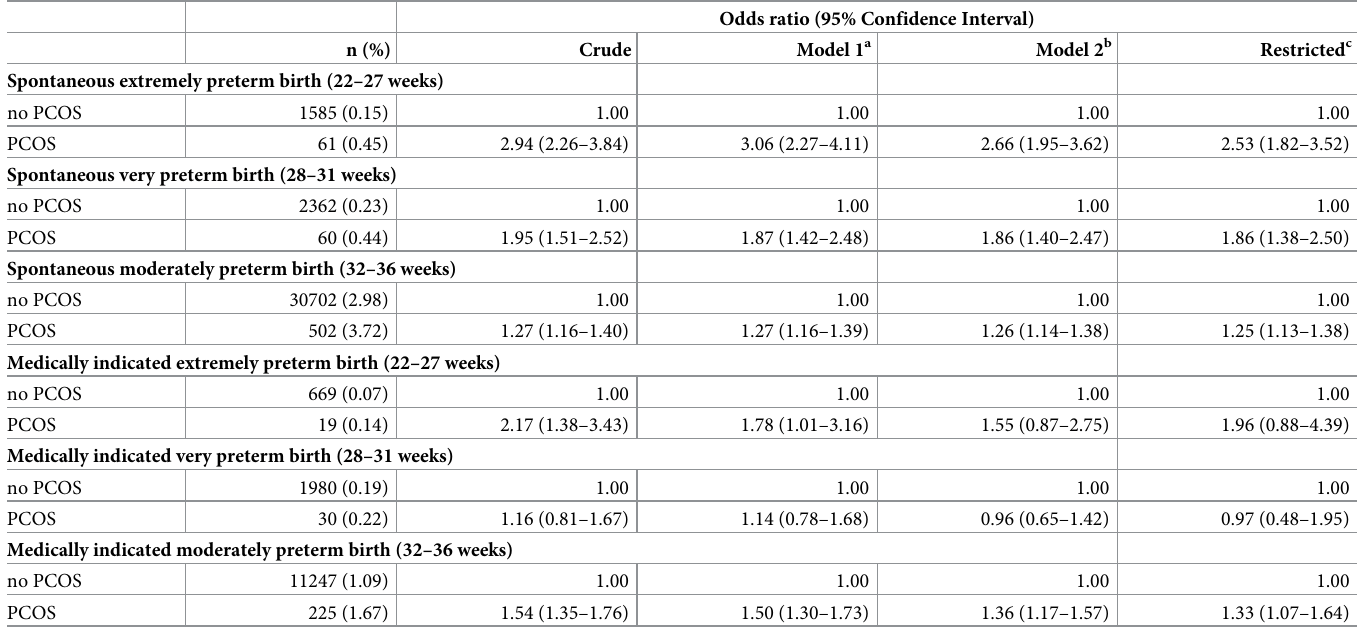
Table 4. Risk of preterm birth in women with PCOS by mode of onset of delivery; preterm birth divided into extremely, very and moderately